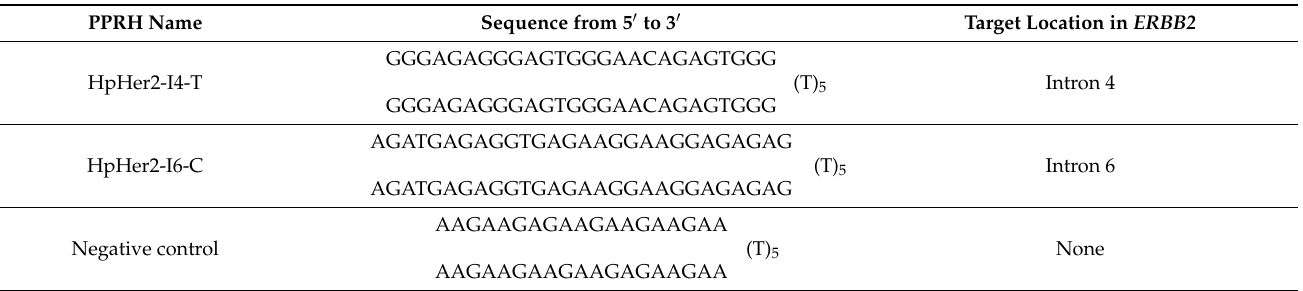
Table 4. PPRH sequences used in this